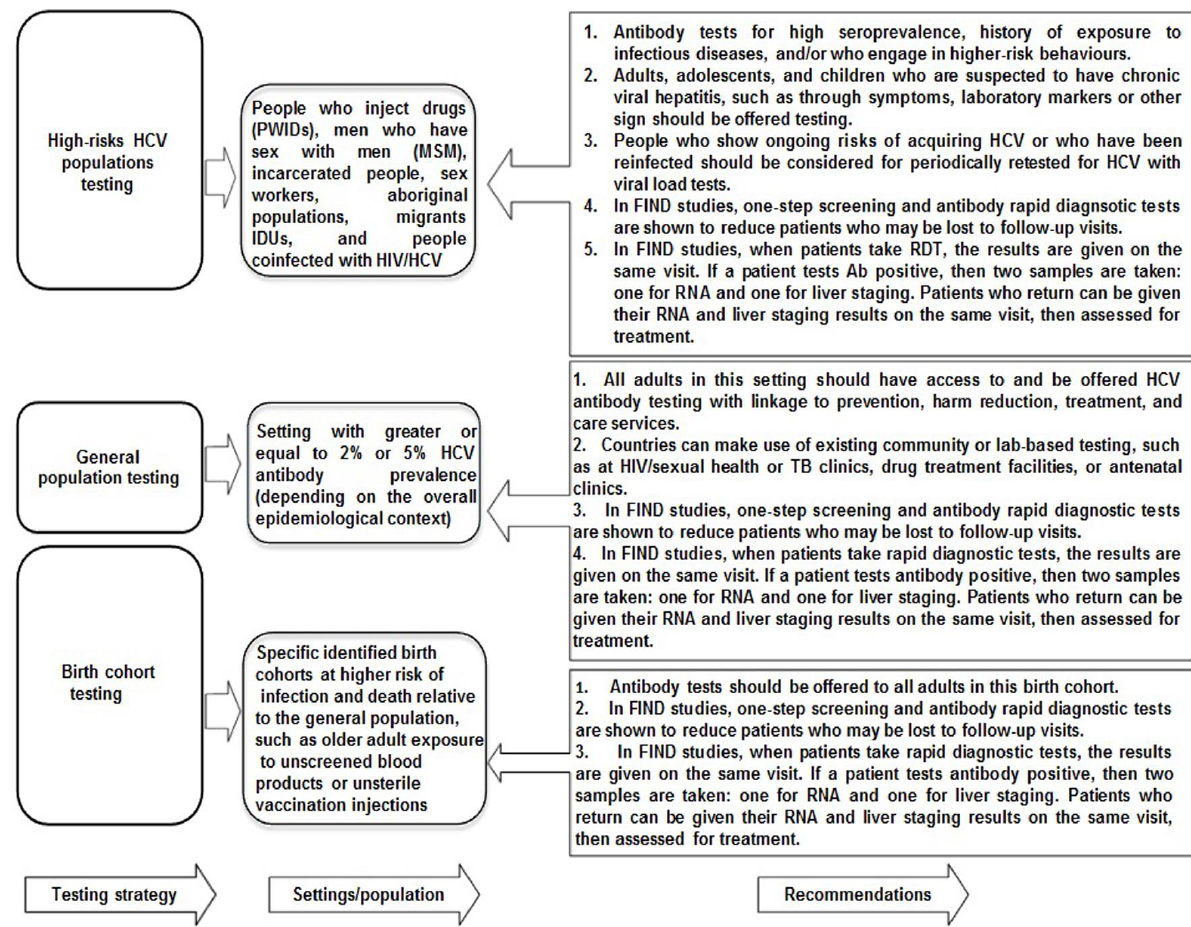
Figure 6. WHO guidelines focusing on three testing strategies for the screening of new HCV incidences in countries with high risks HCV populations, with anti-HCV Abs prevalence greater or equal to 2% or 5%, and birth cohort screening. (Source; Activist Guide to Hepatitis C Virus Diagnostics; Available online: https://www.hepcoalition.org/advocate/advocacy-tools/article/activist-guide-to-hepatitis-c-virus-diagnostics; accessed on 2 April 2021).